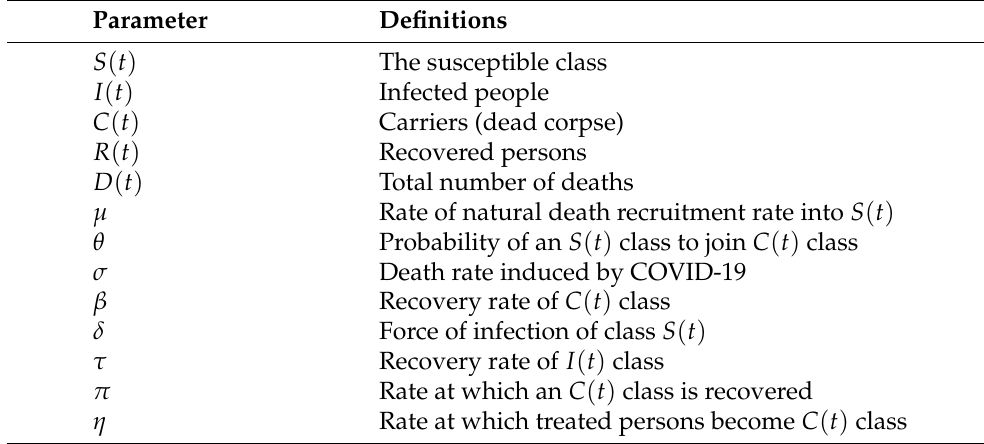
Table 1. The definitions of the